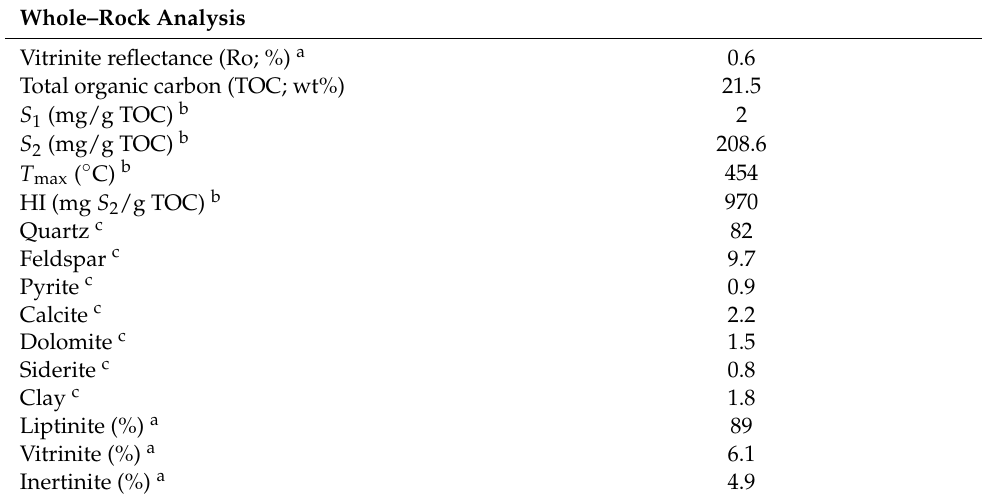
Table 1. Geochemical characterization of the original unheated shale sample used for pyrolysis.